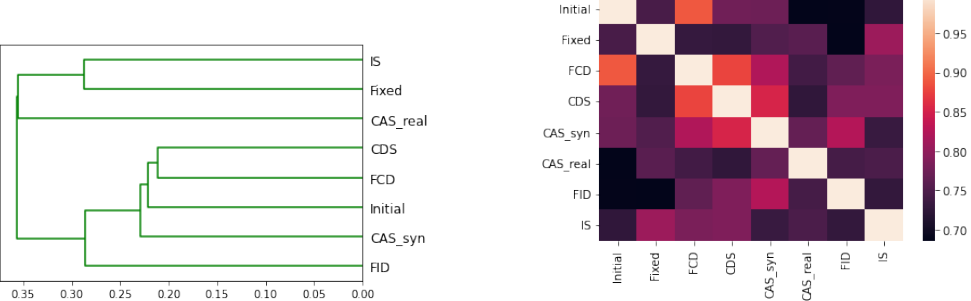
Figure 22. The Pearson correlation heatmap and dendrogram plots of the minority class of the experiments on color imagery datasets (cifar17-based).